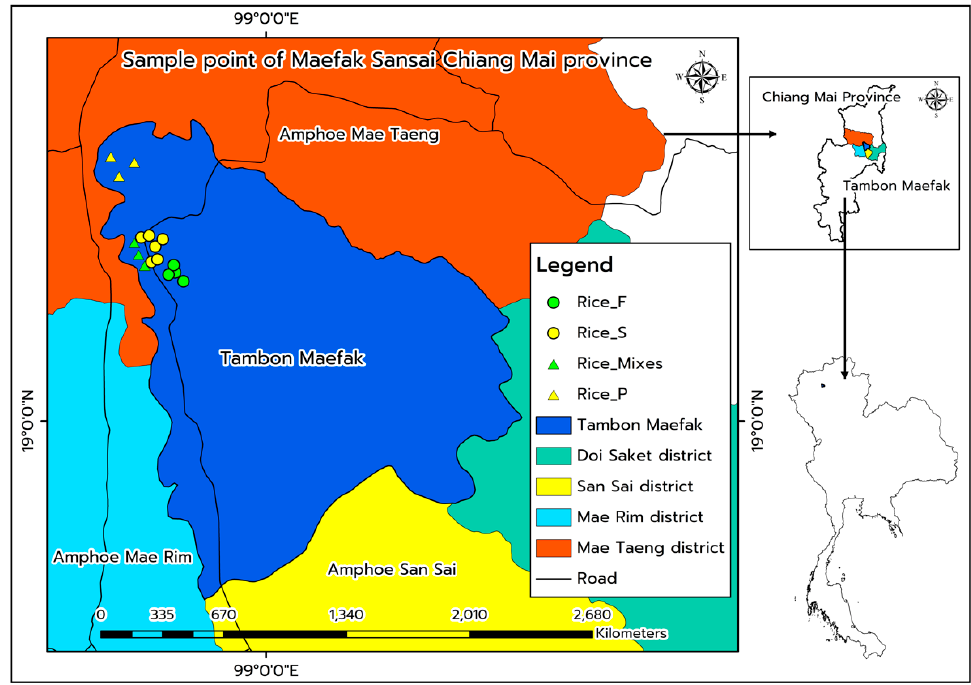
Figure 1. Study sites of soils planted with rice in various rotational patterns: A case study of Mae Fak subdistrict, Sansai district, Chiang Mai province, northern Thailand.